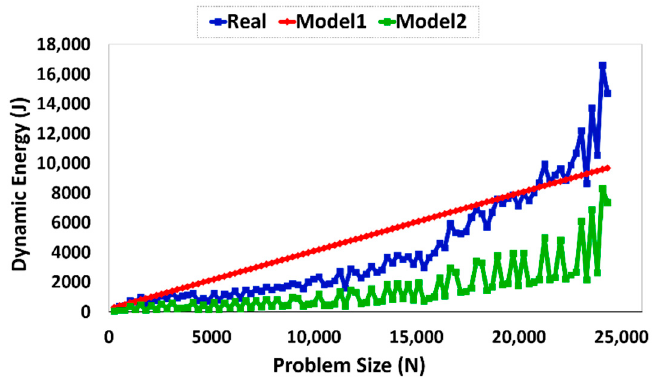
Figure 1. Sample dynamic energy consumption profiles.